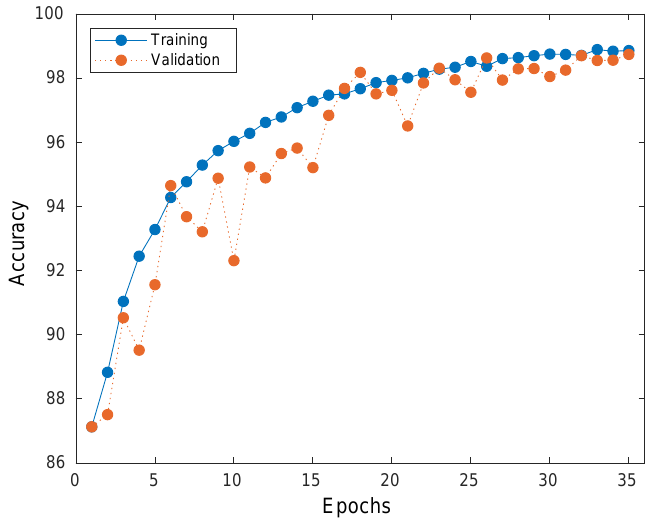
Figure 4. Comparison of